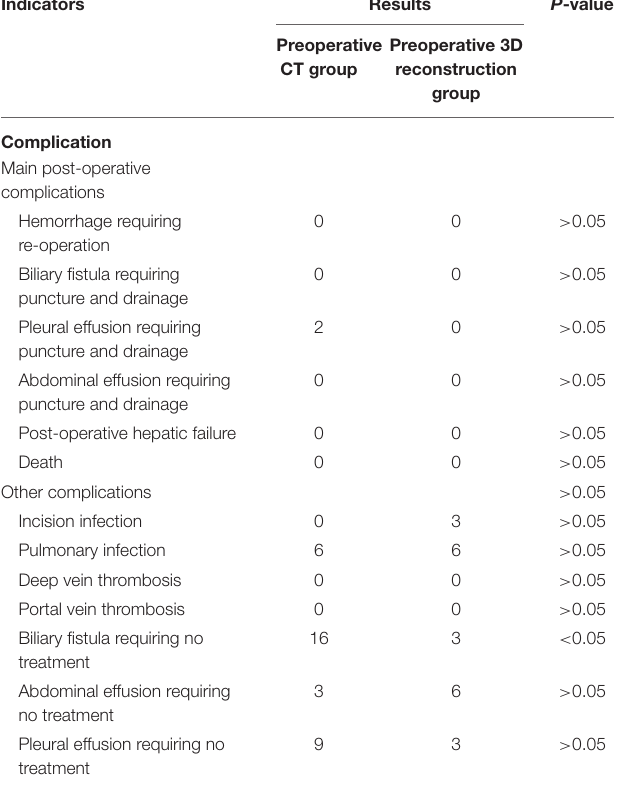
TABLE 5 | Comparison of the postoperative complications between the preoperative CT group and the preoperative three-dimensional reconstruction group.